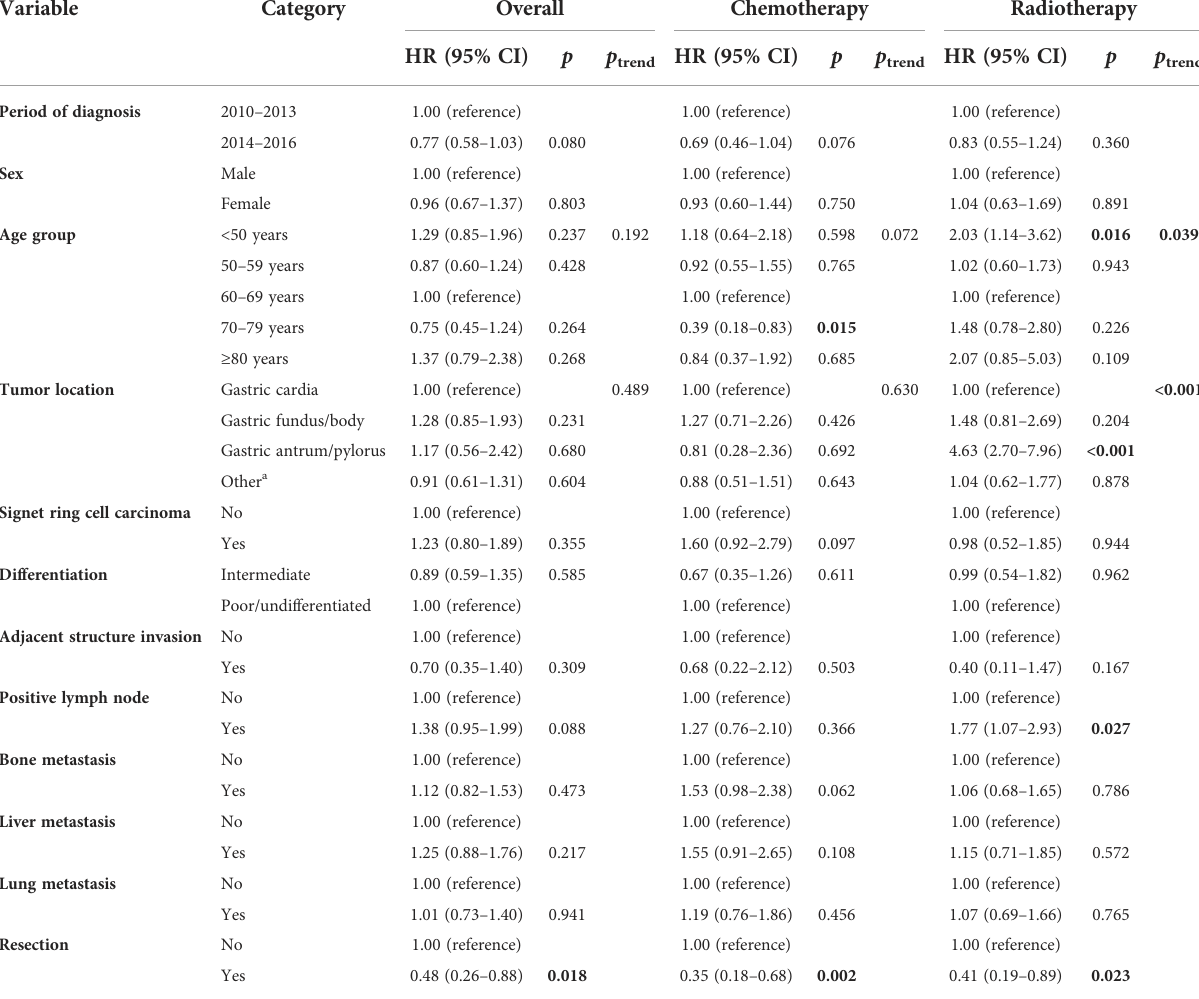
TABLE 4 Fine – Gray subdistribution hazard ratios for cancer-speci fi c mortality among cases with gastric adenocarcinoma and brain metastasis in overall patients and those treated with chemotherapy or radiotherapy. Variable Category